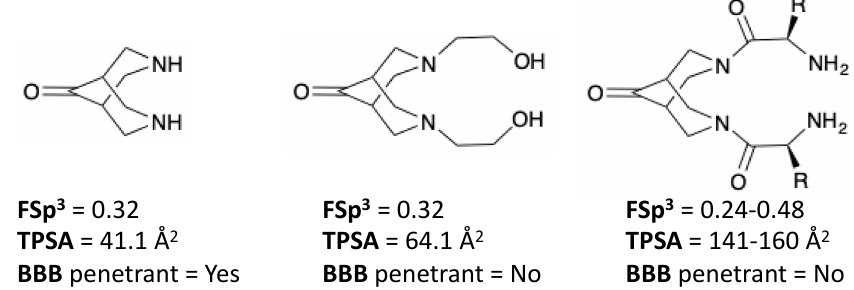
Figure 1. SwissADME (http://www.swissadme.ch) predicted properties of a selected series of bispidinone analogues. The introduction of N-substituents facilitated modulation of the fraction of sp3 hybridized carbon atoms (Fsp 3 ) character, increased topological polar surface area (TPSA), and predicted no blood brain barrier (BBB) penetration.